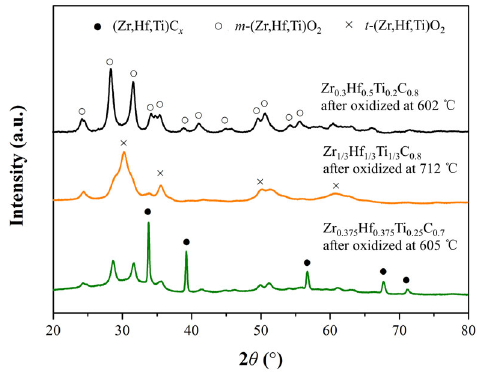
Fig. 13 XRD patterns of the oxidation products of Zr 0.3 Hf 0.5 Ti 0.2 C 0.8 , Zr 1/3 Hf 1/3 Ti 1/3 C 0.8 , and Zr 0.375 Hf 0.375 Ti 0.25 C 0.7 after being oxidized at 602, 712, and 605 ℃ ,